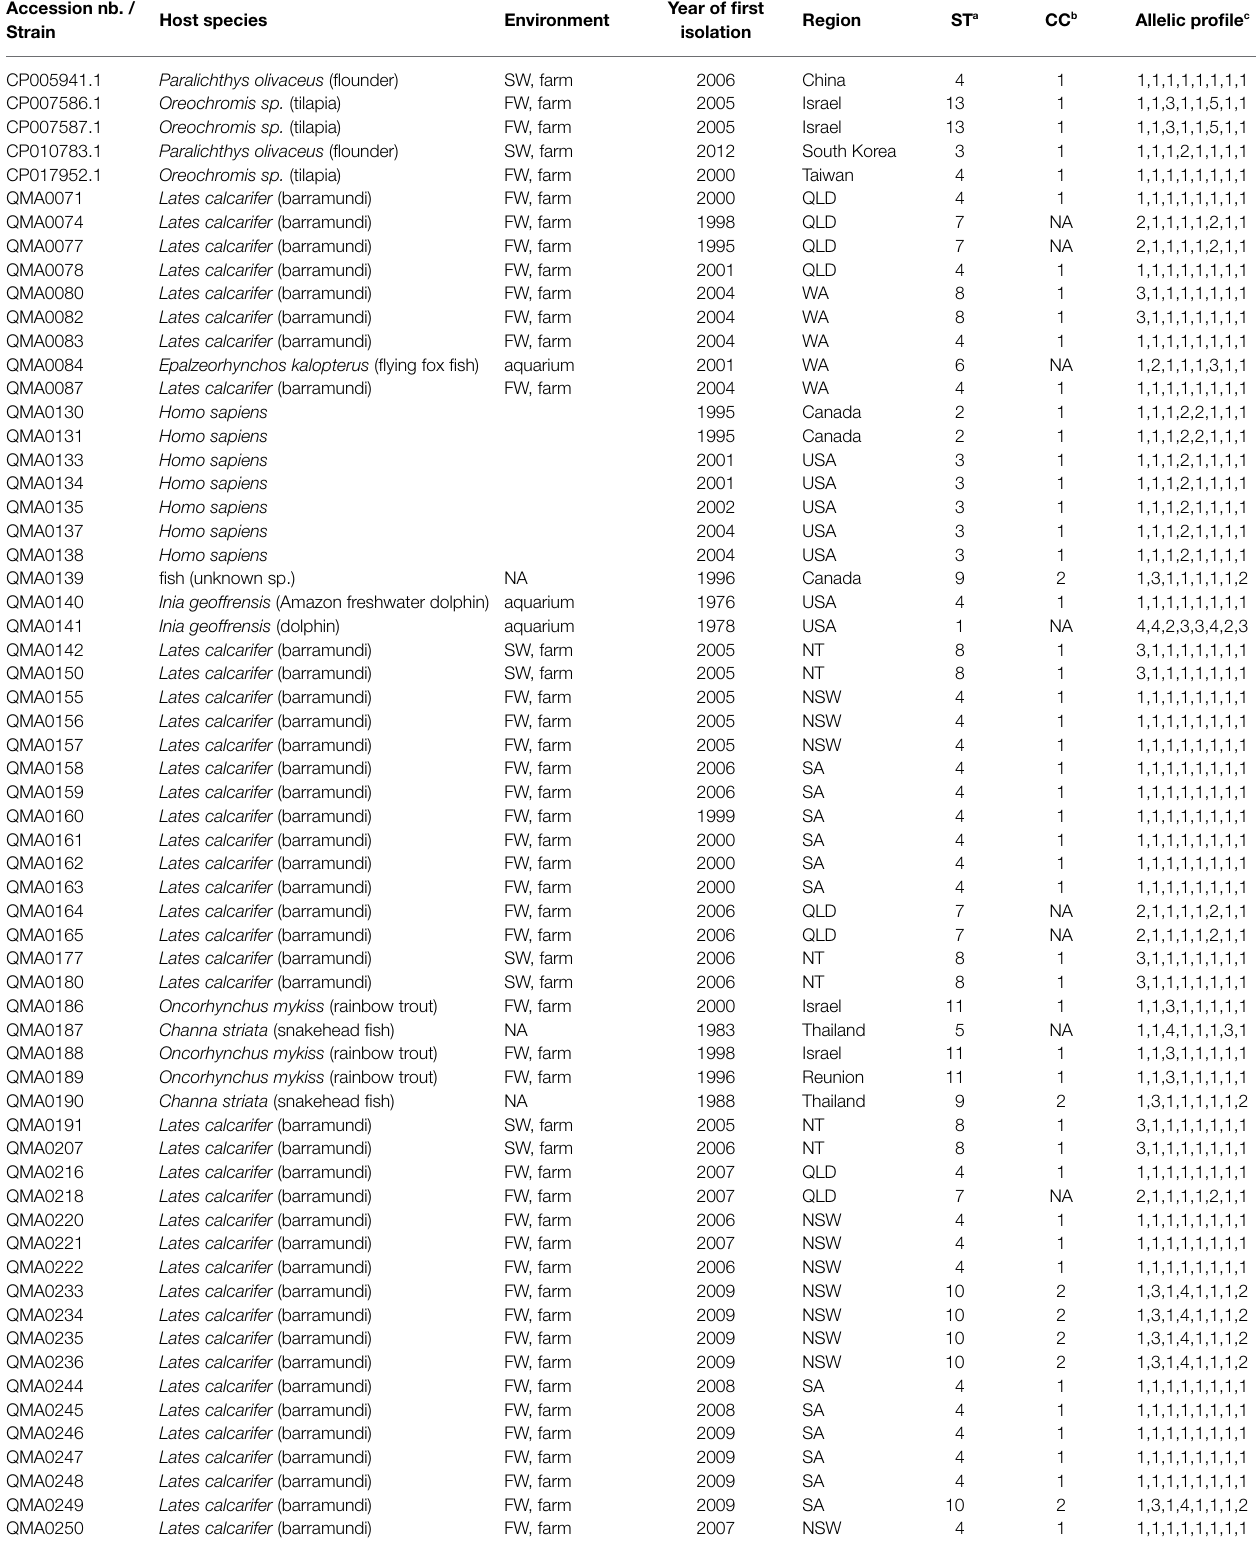
TABLE 1 | Origin and typing of S. iniae strains. For Australian strains, region of isolation is indicated. Accession nb. / Host species Environment Allelic profile Strain